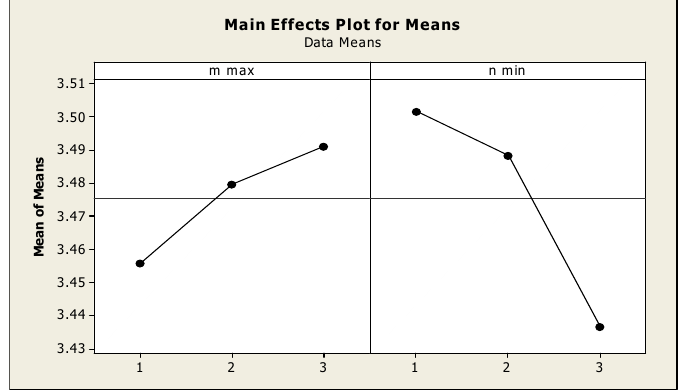
Fig. 9. The output of Minitab software for parameters of the proposed VNS